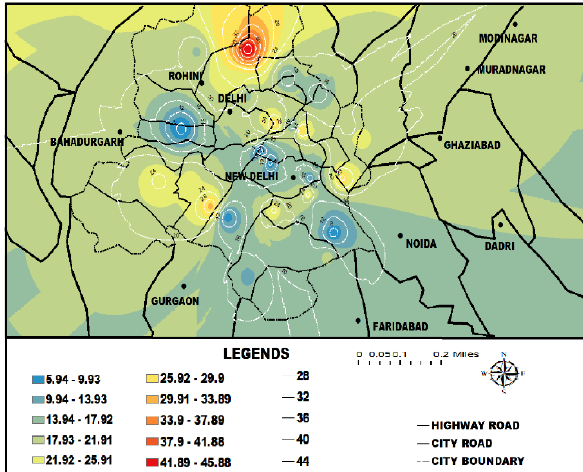
Figure 2. Air quality map of Delhi January monthly average based on NOx (µg/m 3 ).